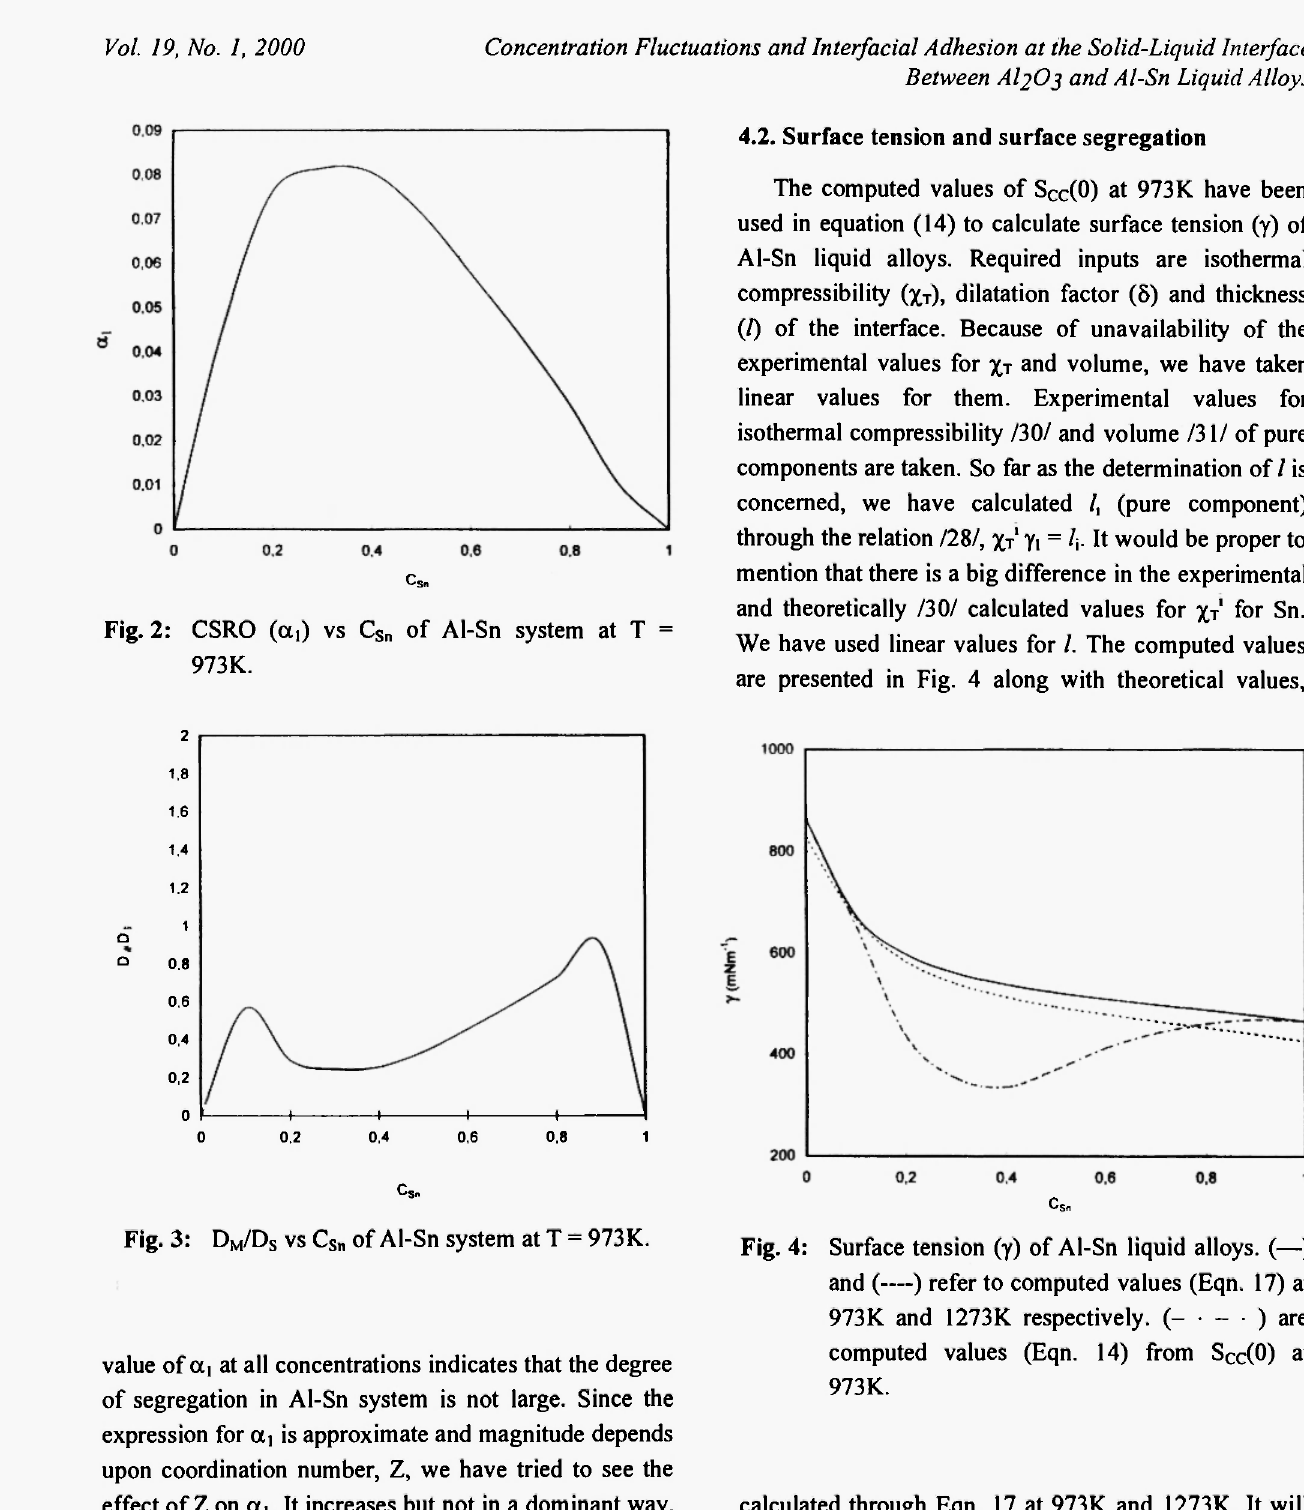
Fig. 3: D M /D S VS C SN of Al-Sn system at Τ = 973K. value of a] at all concentrations indicates that the degree of segregation in Al-Sn system is not large. Since the expression for αϊ is approximate and magnitude depends effect of Ζ on αι. It increases but not in a dominant way.